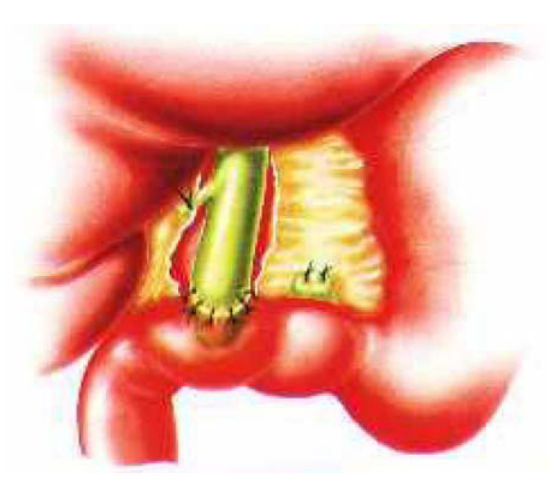
FIGURA 13 - Desenho mostra a anastomose do Grupo II concluída. (Aspecto externo).